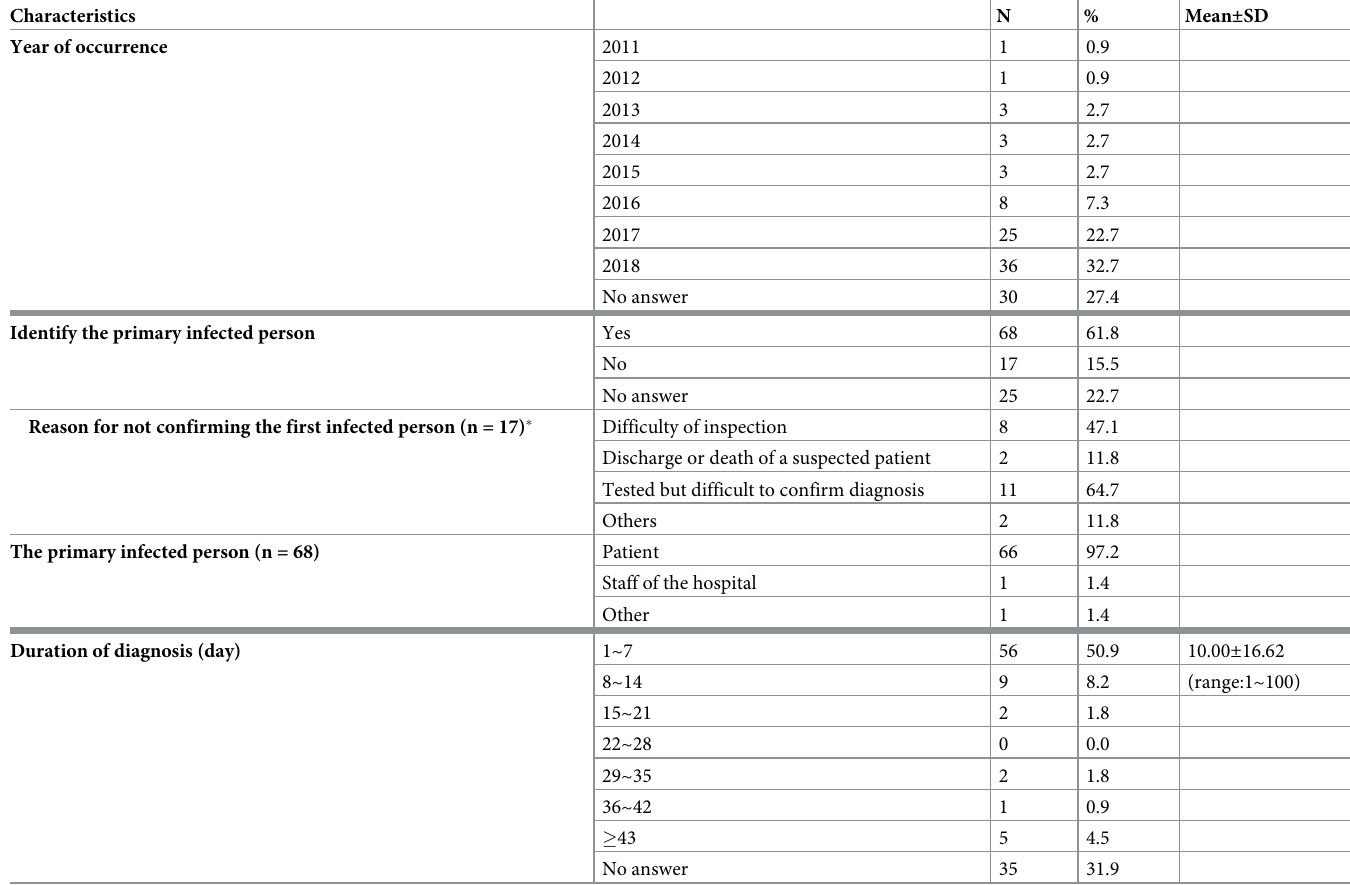
Table 3. Characteristics of the most recently reported scabies cases (N =